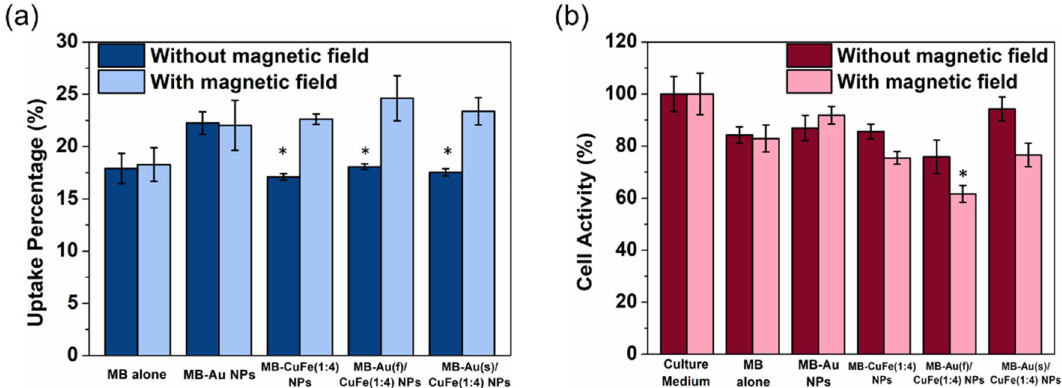
Figure 4. ( a ) Cellular uptake and ( b ) cell activity after 4 h incubation with and without a magnetic field. (n = 4).